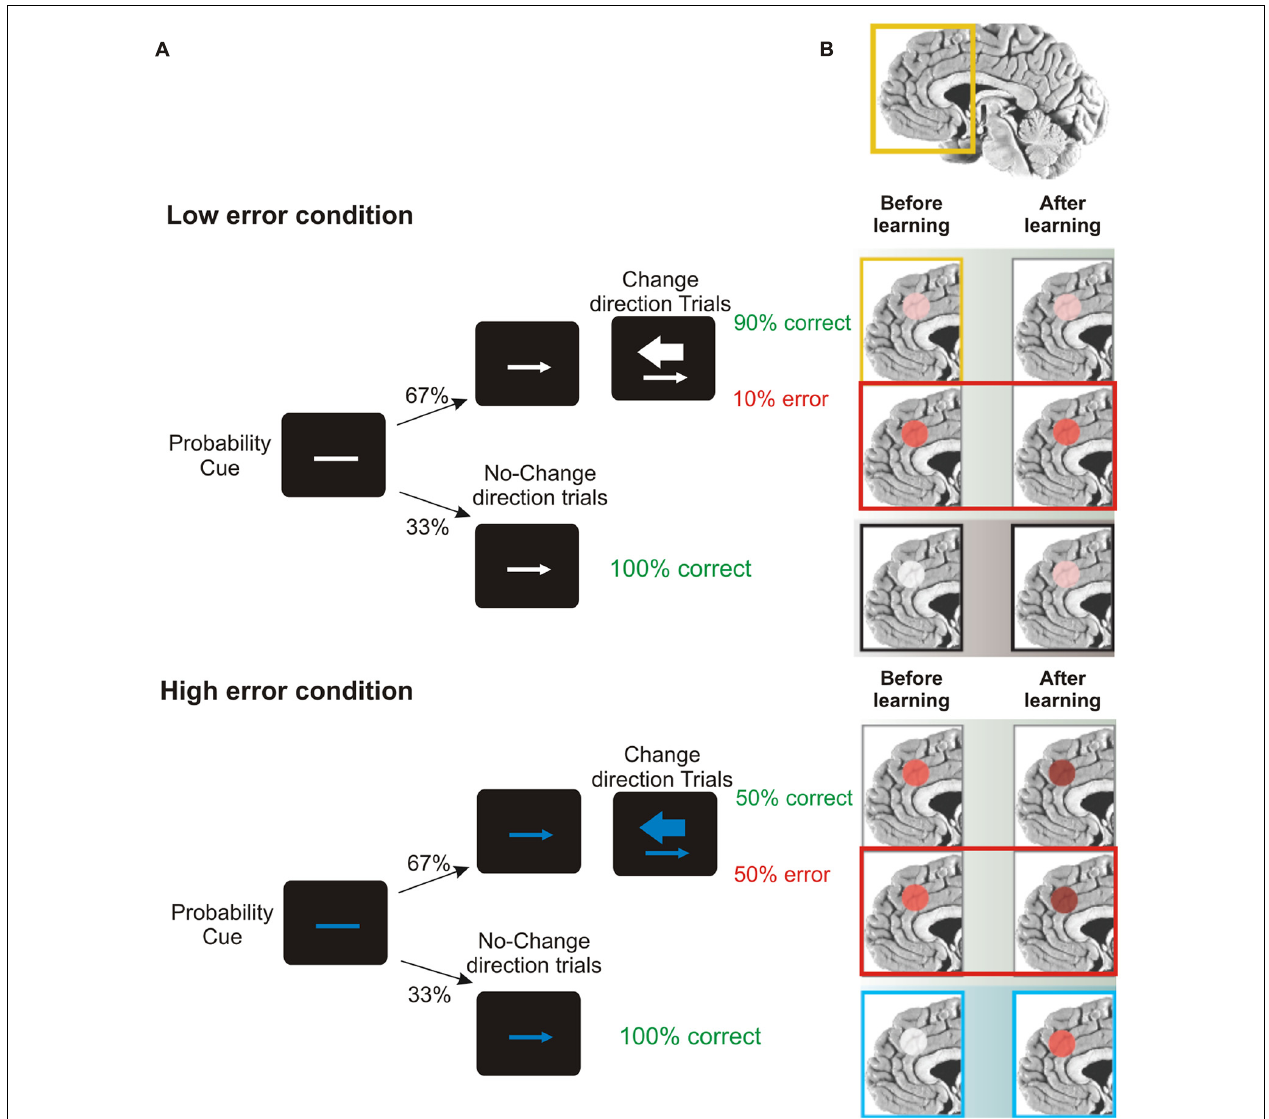
and the change signal was kept shorter and subjects made around 90% of correct responses. In the high error condition the delay was kept longer and subjects made around 50% correct responses. (B) Brain regions highlighted indicate the activation of ACC during the stop-change before and after learning (the greater the activation, the deeper the red color) for correct, wrong change-direction trials and for no-change trials (for the top to the bottom row) in the low and high error conditions. Interestingly, during no-change trials ACC activity increased with practice, especially in response to blue color cues, reflecting an improved ability to predict the likelihood of making an error. Freely adapted from Ridderinkhof and van denWildenberg (2005), with